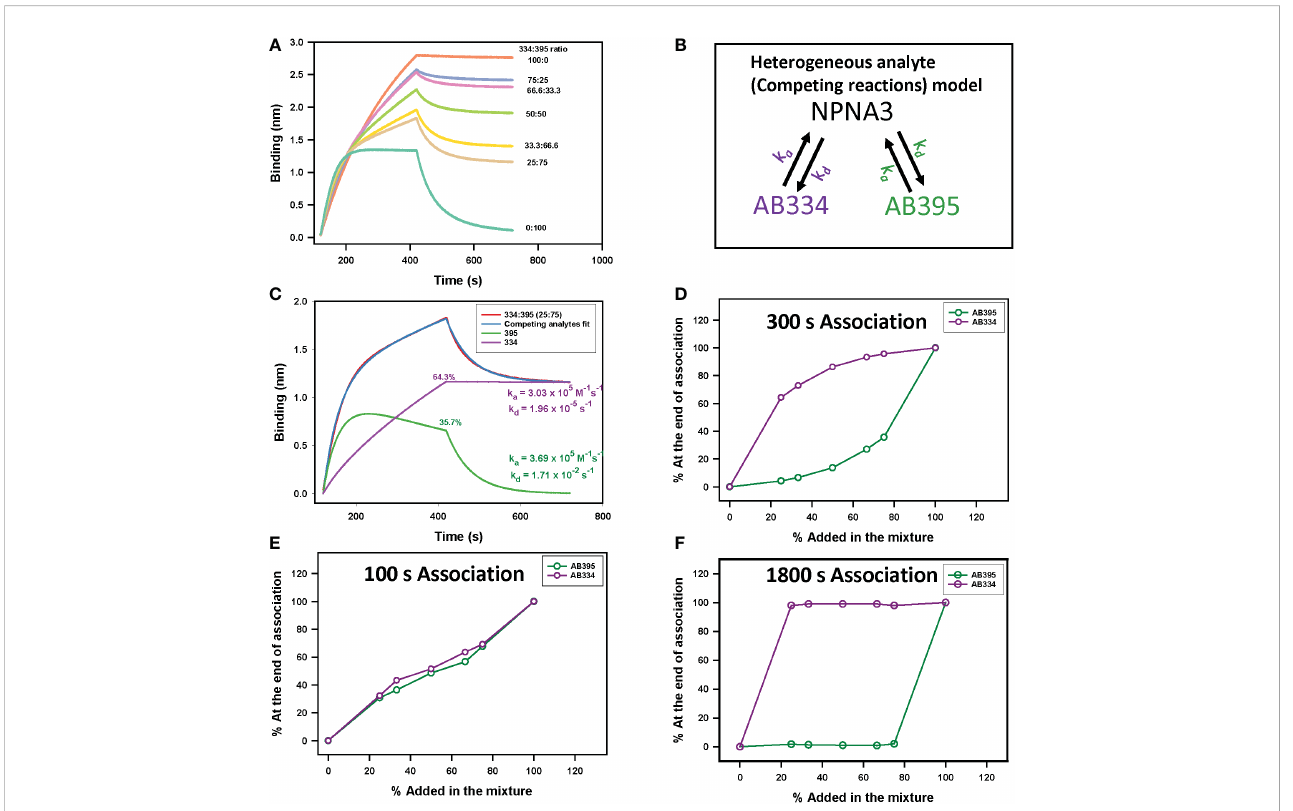
FIGURE 3 Epitope occupancy dynamics in binary antibody mixtures. (A) NPNA3 peptide binding time-courses of 5 µg/ml of a high avidity antibody AB334, a low avidity antibody AB395, and these two mAbs mixed at different ratios maintaining a total concentration of 5 µg/ml are shown. (B) Schematic of a heterogeneous analyte (competing reactions) model used to dissect total binding into component antibody binding kinetics is shown. The mAbs AB334 (purple) and AB395 (green) compete for binding to the immobilized antigen NPNA3. The k a and k d of each mAb are color coded to match the respective mAb. (C) Resolution of component antibodies binding time-courses contributing to the total observed binding of AB334 and AB395 mixed at 25:75 ratio predicted by a competing analytes model fi t. (D – F) Plots of fraction of response of antibodies bound at the end of association phase (D) 300 s, (E) 100 s and (F) 1800 s respectively) for different compositions of the binary mixture are